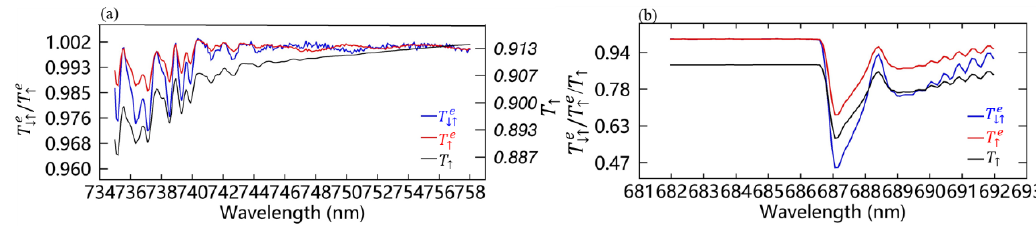
Figure 12. Example of the estimated effective two-way atmospheric transmittance ( 𝑇 ↓↑𝑒 , shown in blue) and the effective upward transmittance ( 𝑇 ↑𝑒 , shown in red) plotted against the true upward transmittance ( 𝑇 ↑ , shown in black) at far-red band ( a ) and red band ( b ) based on simulations with an SR of 0.3 nm and SNR of 322.